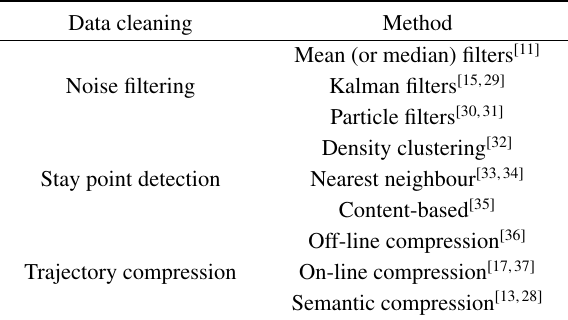
Table 1 Summary of existing trajectory data cleaning methods.